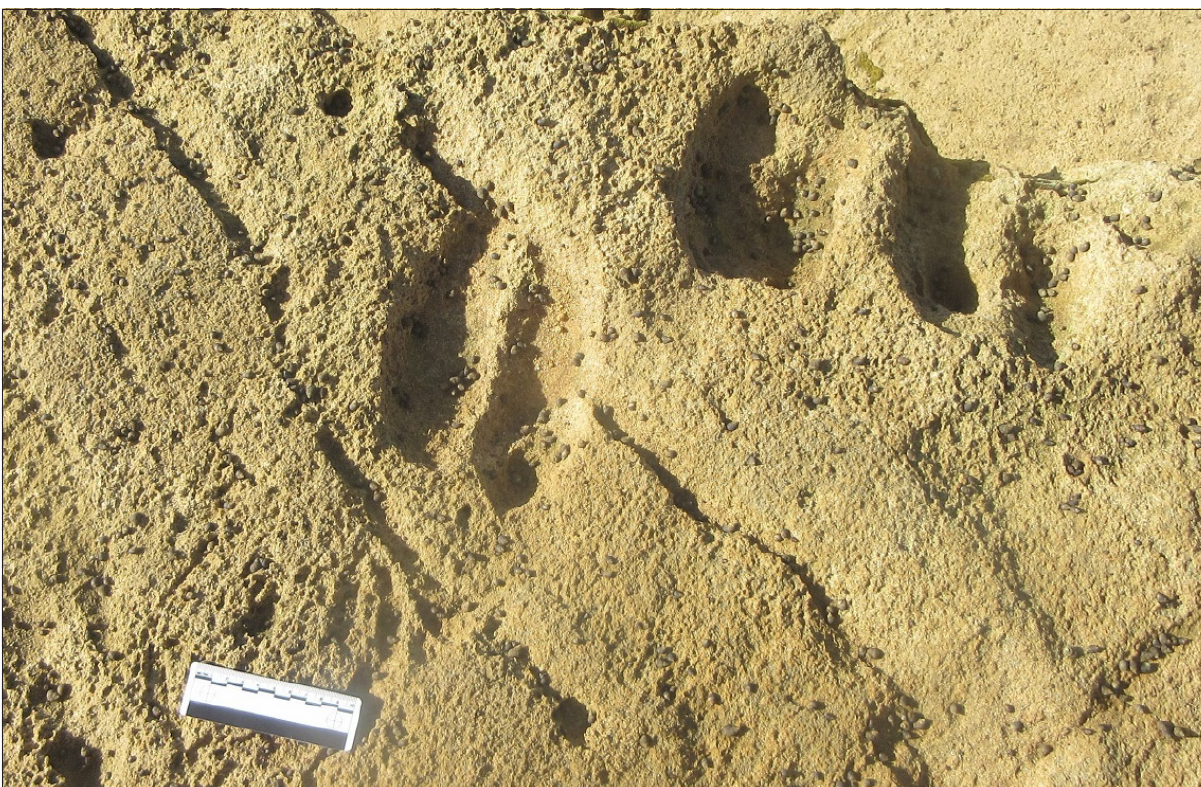
Figure 4: Detail of four giraffe tracks. The best preserved adult track is left of centre, and the best preserved purported juvenile track appears below it, above the top right corner of the 10-cm scale